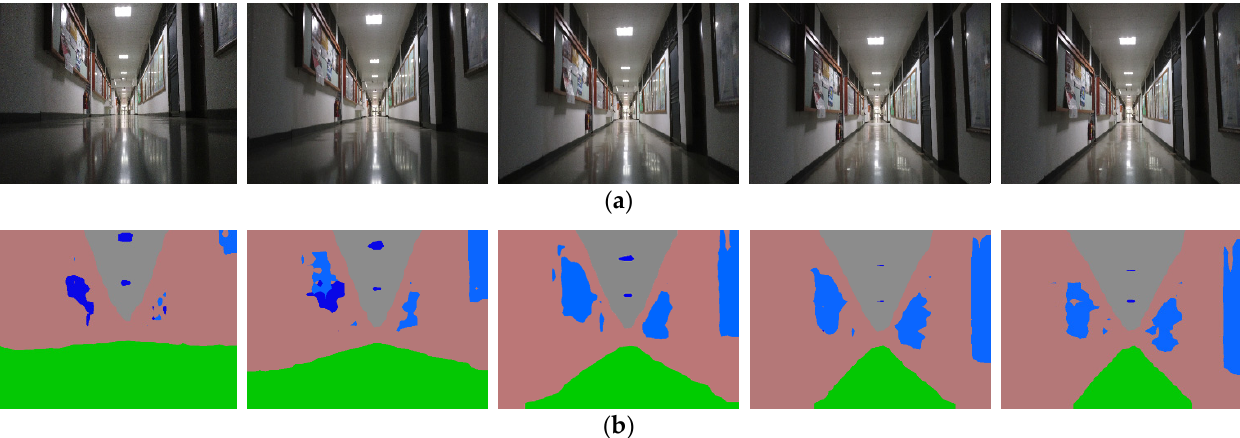
Figure 11. Segmentation results: ( a ) RGB images and ( b ) segmentation images.